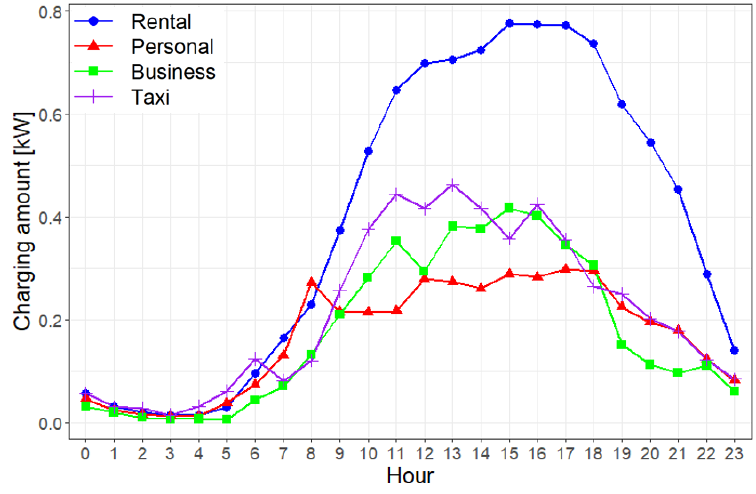
Figure 4. Monthly average EV charging pattern per hour by type.